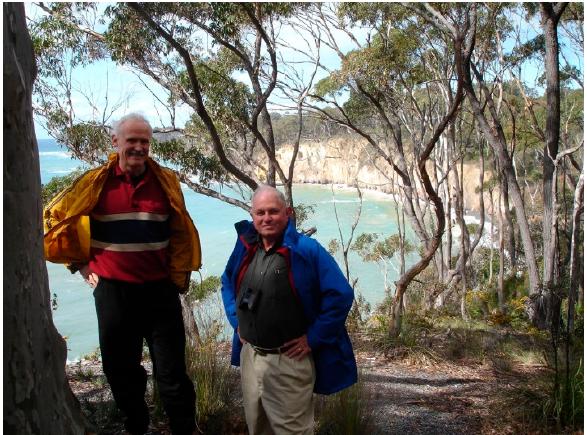
Figure 5. Ian Jackson and the author at Lilli Pilli, Australia, 2006.